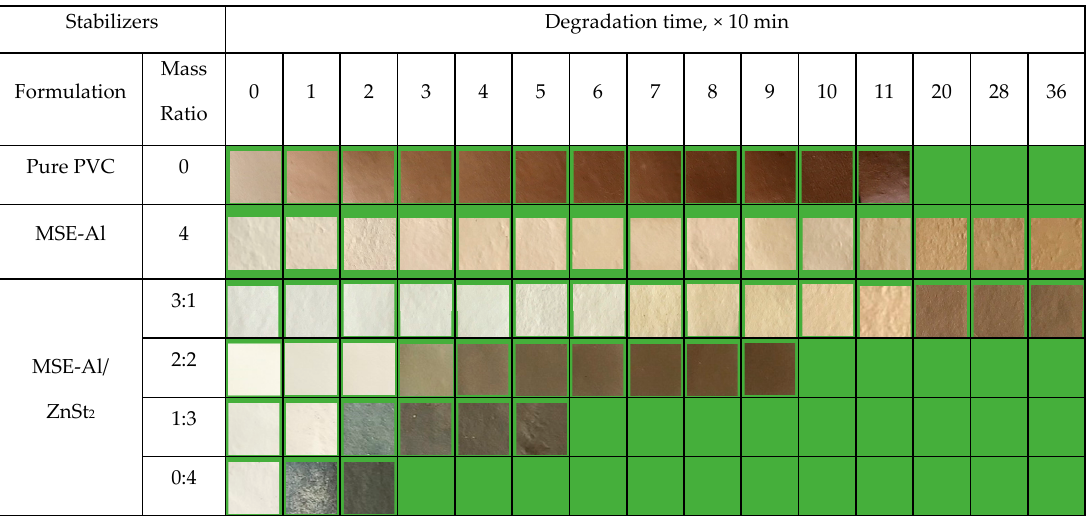
Figure 7. Results of thermal aging tests for pure PVC and PVC stabilized by 4 phr of MSE-Al or different mass ratios of MSE-Al and ZnSt 2 when heated at 180 °C in an oven.